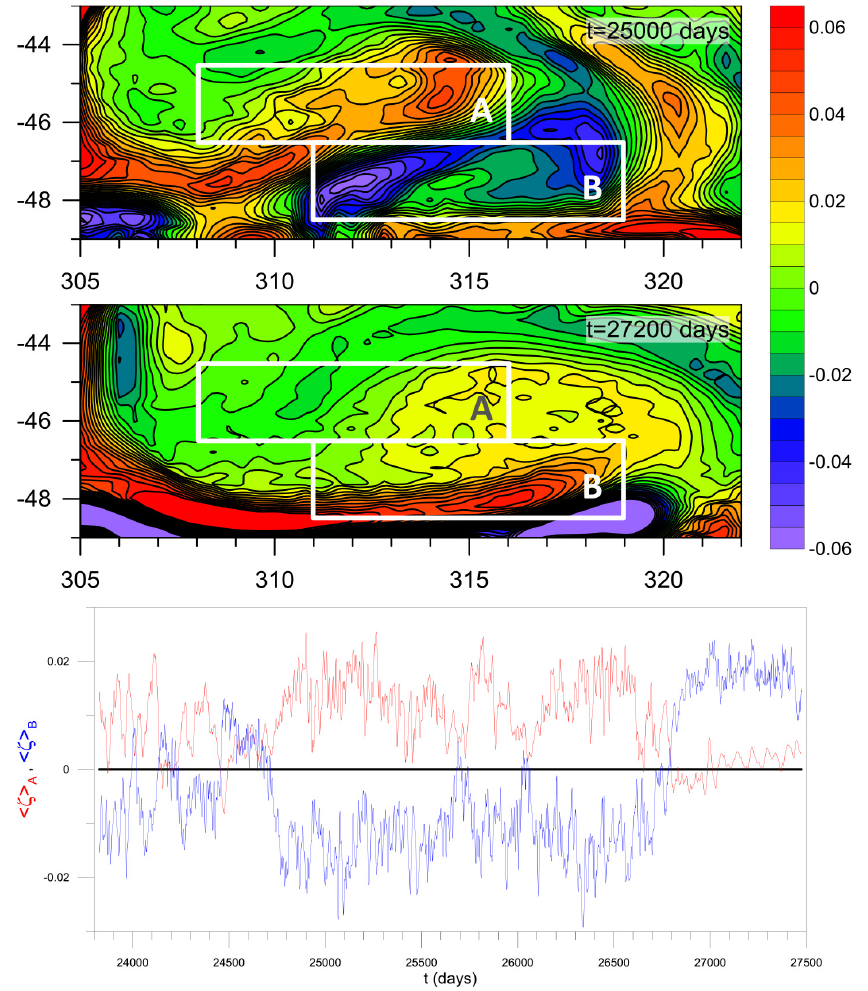
Fig. 10. Upper panels: low-frequency relative vorticity ˜h ζ i at t = 25000 and t = 27200 days. Lower panel: time series of h ζ i averaged in sectors A and B for the 10-year reference